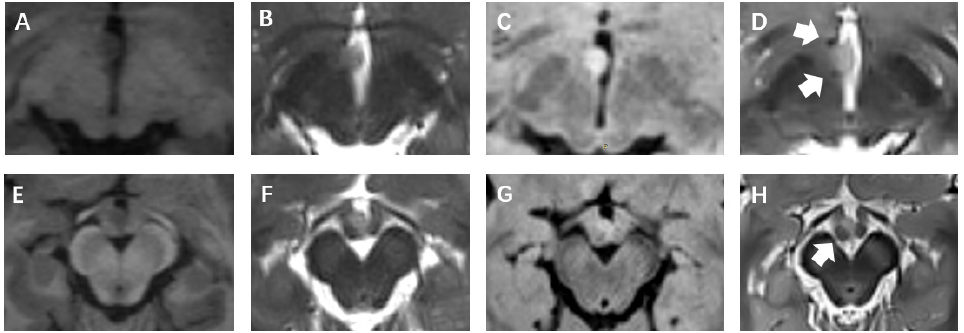
Figure 2. ( A , E ) T1-MPRAGE. ( B , F ) 3D-T2WI TSE. ( C , G ) 3D-T2WI FLAIR. ( D , H ) T2-STIR. The white arrows in ( D ) point to the fornix and mammillothalamic tract, respectively. In ( H ), it points to the mammillary body.